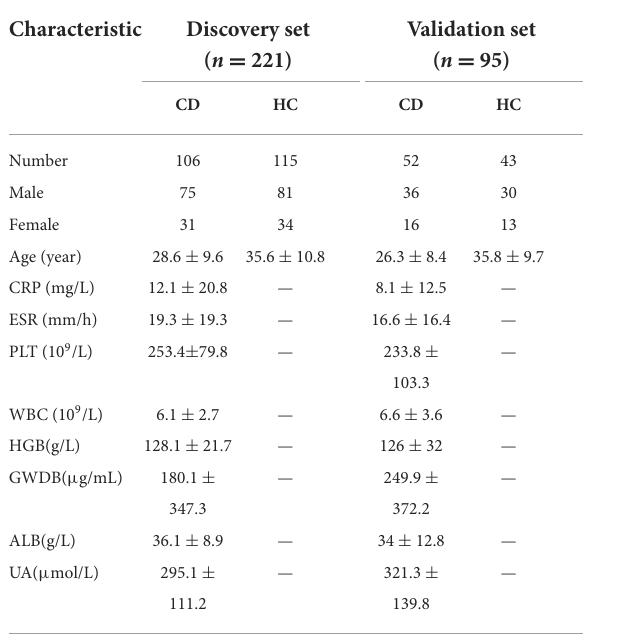
TABLE 1 Clinical characteristics of the subjects.